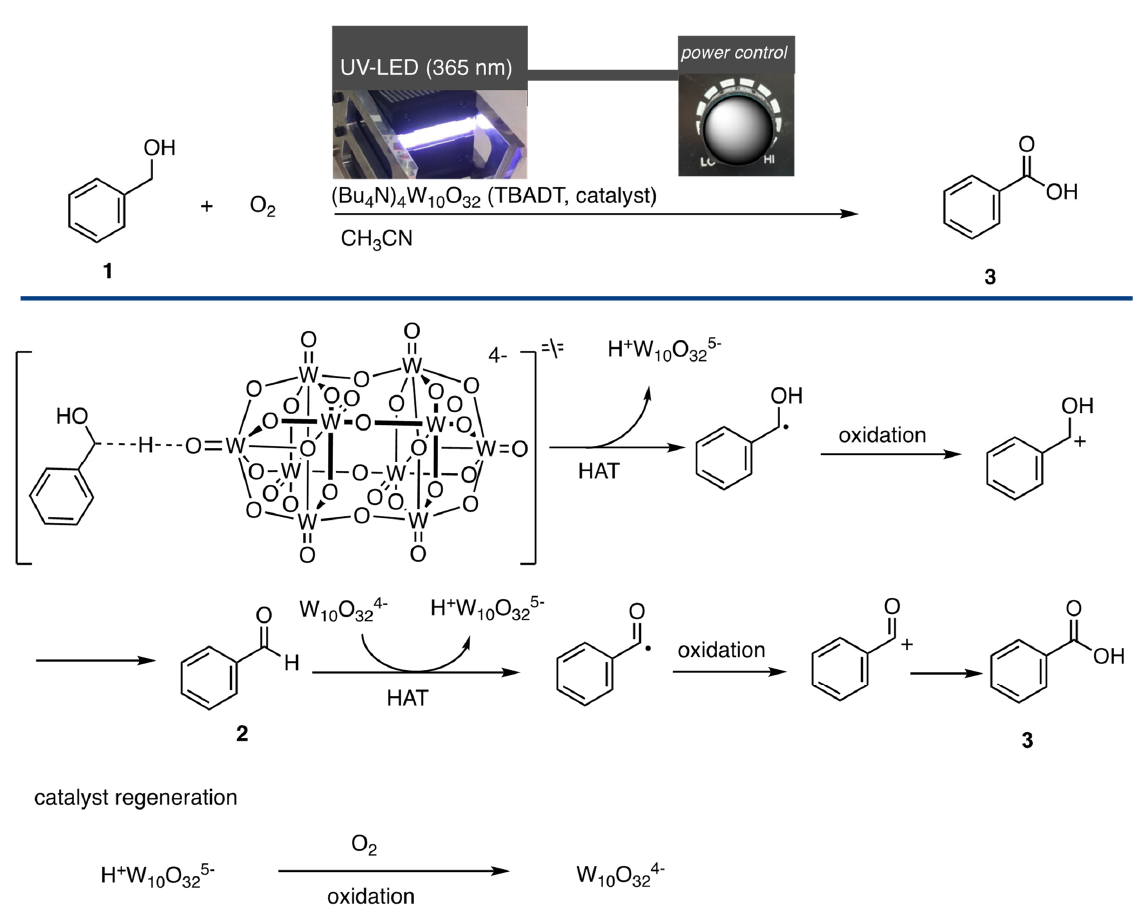
Figure 1. UV-VIS Spectrum of decatungstate anion in acetonitrile (1.1 × 10 − 4 M, TBADT (Bu 4 N) 4 W 10 O 32 ).